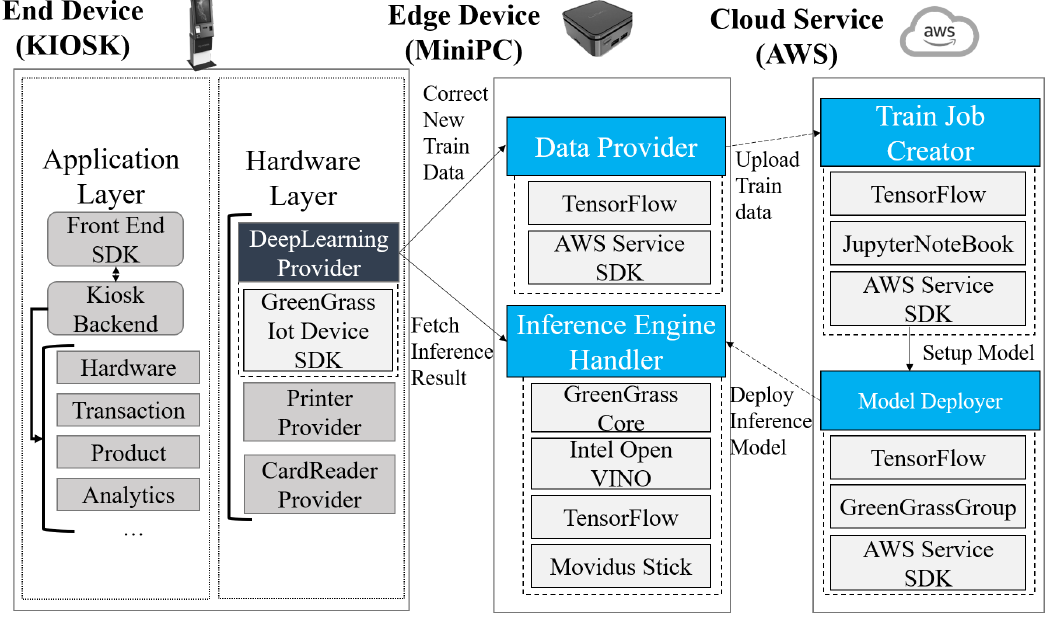
Figure 2. The system archicture of the MiniDeep